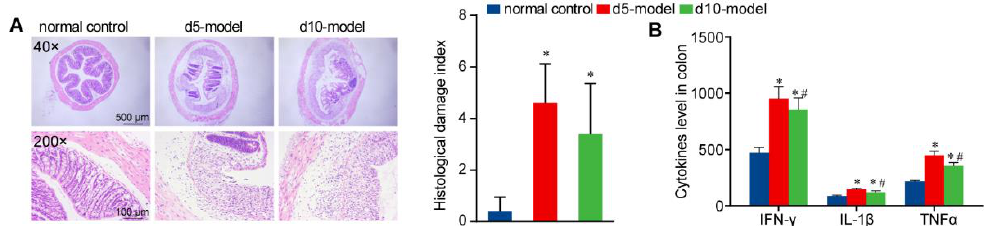
Figure 2. Inflammatory conditions of IBD mouse model. ( A ) Representative images of the colon by H&E staining (40 × and 200 × ). ( B ) Score of inflammation-associated histological changes in colon. ( B ) The concentration of IFN- γ , IL-1 β and TNF- α in serum, n = 9. Data are means ± SD and analyzed by a one-way ANOVA followed by Tukey’s multiple comparisons test. * p < 0.05 compared with the normal control group; # p < 0.05 compared with the d 5 model group.